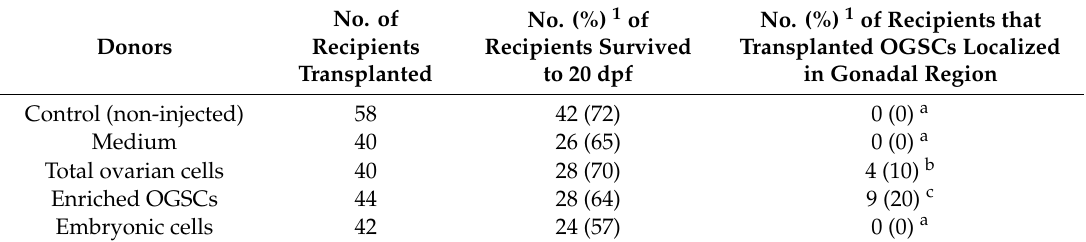
Table 2. Rates of localization in the gonadal region after transplantation of OGSCs enriched by PDGC and DP into 11 days post-fertilization (dpf) larvae.